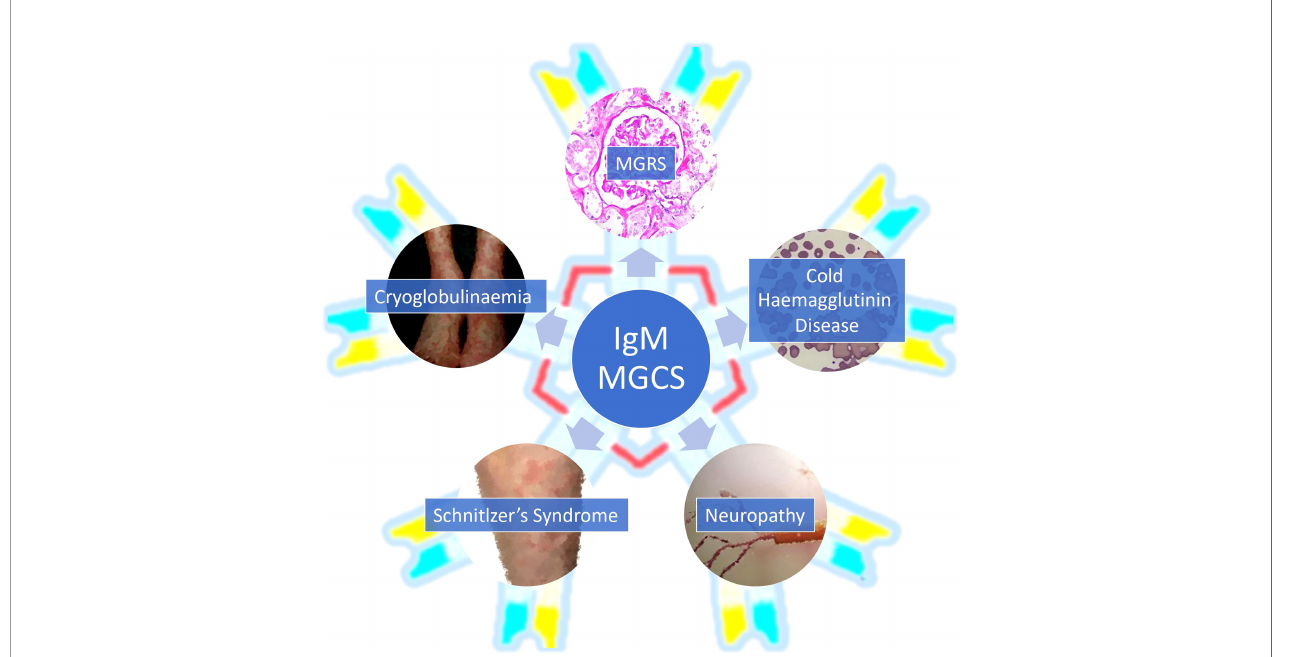
FIGURE 1 | An overview of the clinical presentations associated with IgM monoclonal gammopathy of clinical signi fi cance. MGCS, monoclonal gammopathy of clinical signi fi cance; MGRS, monoclonal gammopathy of renal signi fi